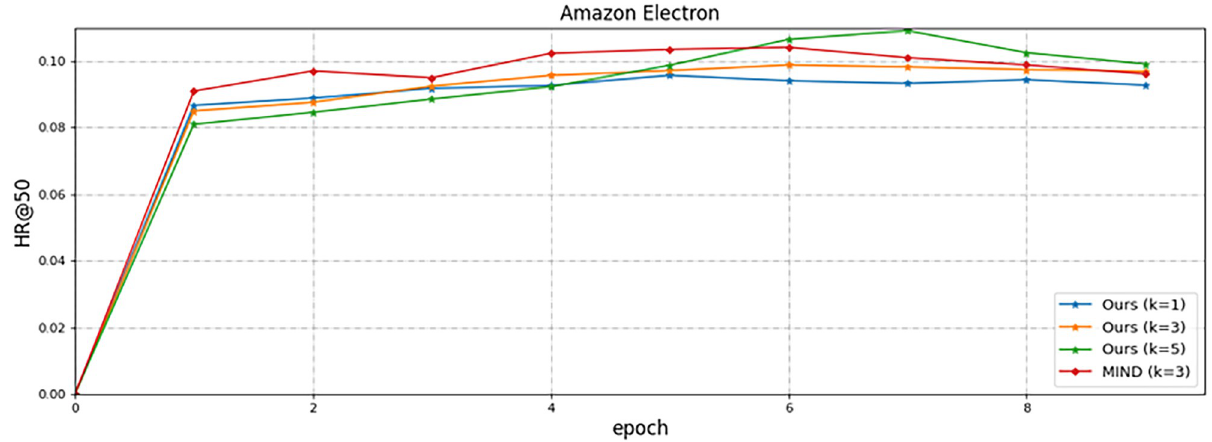
Fig 4. Performance comparison of different numbers of interest K in MIRN. The y-axis represents the value of HR@50 and the x-axis gives the number of iterations. MIRN performs better with bigger K .